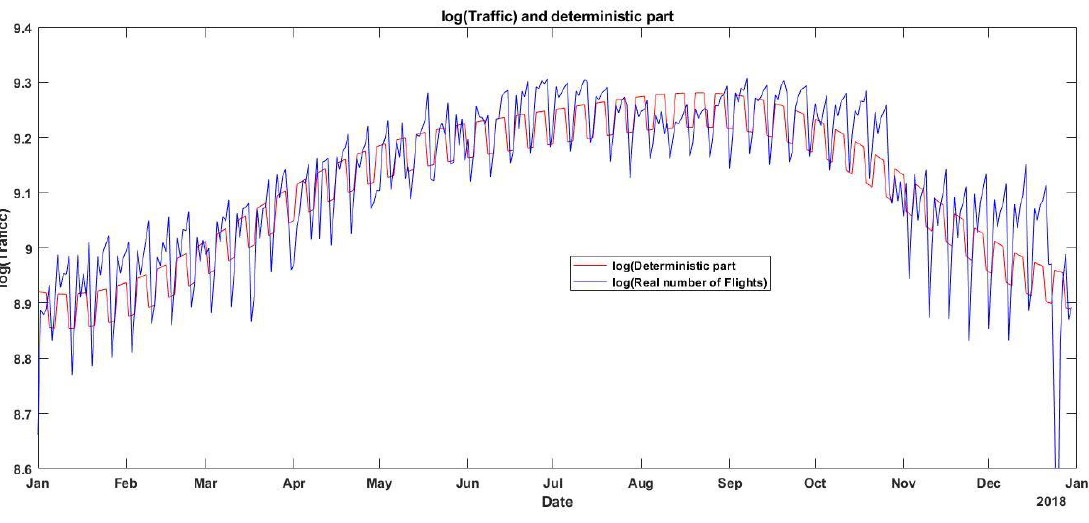
Figure 5. Number of flights (2018) and its deterministic